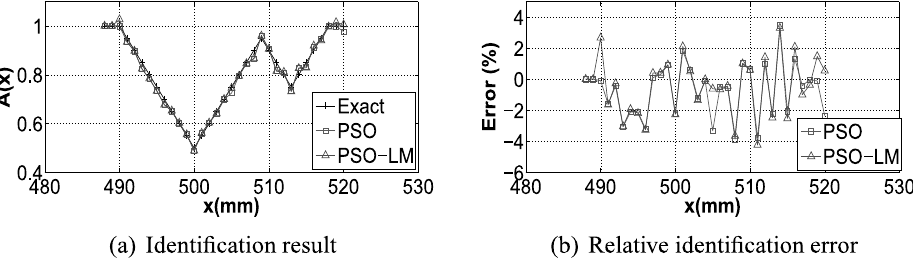
Fig. 23. Identi fi cation with SNR = 10 dB for Case 3 and short rectangular pulse.